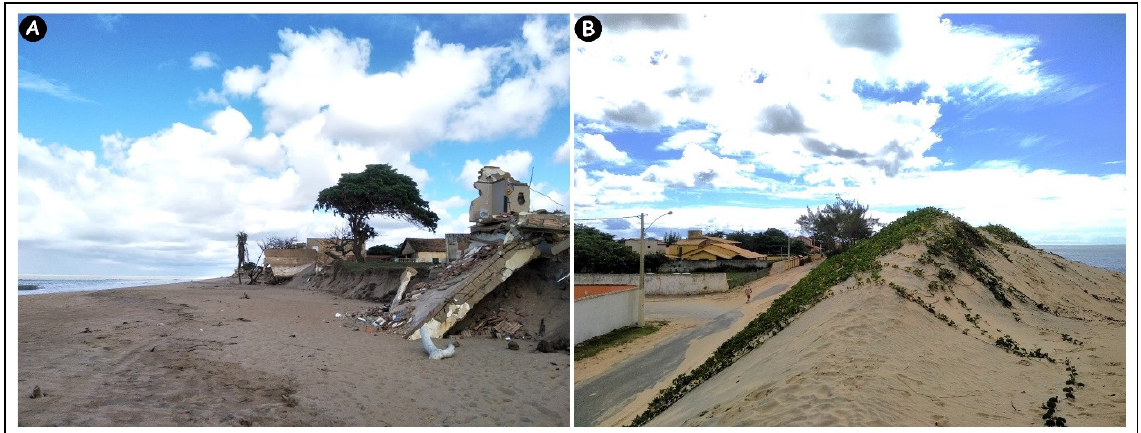
Figure 6. Example of erosive processes in the intense erosion zone. ( A ) Area located in sector 1 with active erosion processes in urban structures (NW-SE view); ( B ) area located in sector 2 showing direct contact of the foredunes with the ocean and their advancement over roads and residences (S-N view). For the locations of the photos, see Figure 5. Photo by: L. Lämmle, 2021.